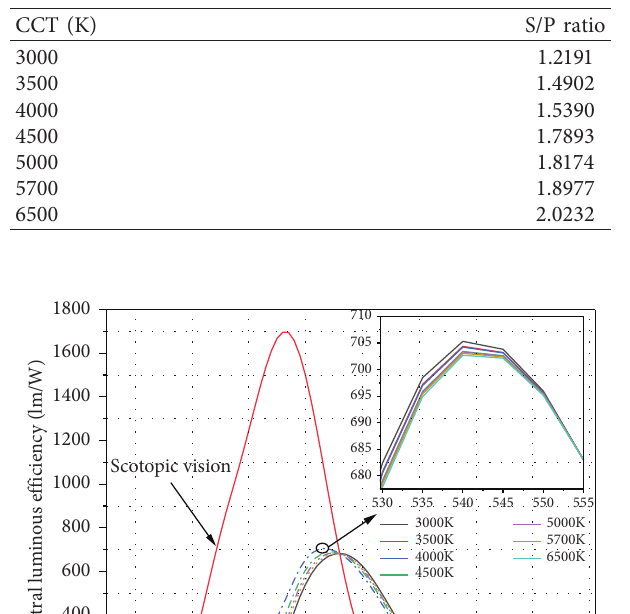
Table 1: The S/ P value of seven light sources.